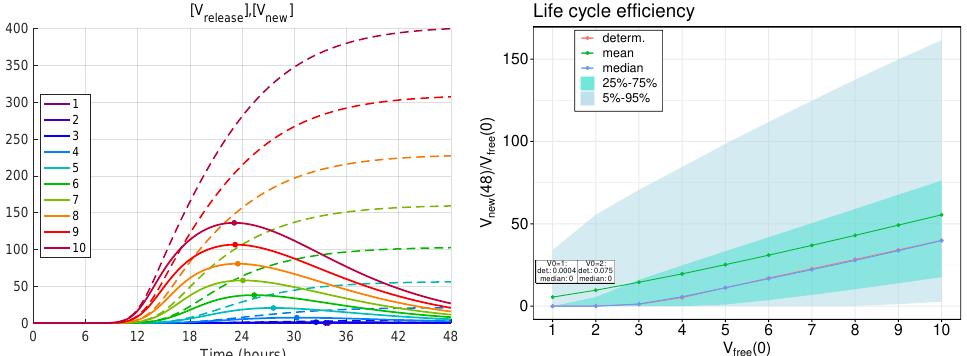
Figure 7. ( Left ) Kinetics of the total number of new virions secreted by an infected cell (dotted lines) for different MOIs (explained by the colour code) and the kinetics of virions release (solid lines) computed by the deterministic model [19]. ( Right ) The life cycle efficiency computed by the deterministic model (the red curve with circles). The mean, median, and the confidence intervals of the life cycle efficiency computed by the stochastic model (explained in the